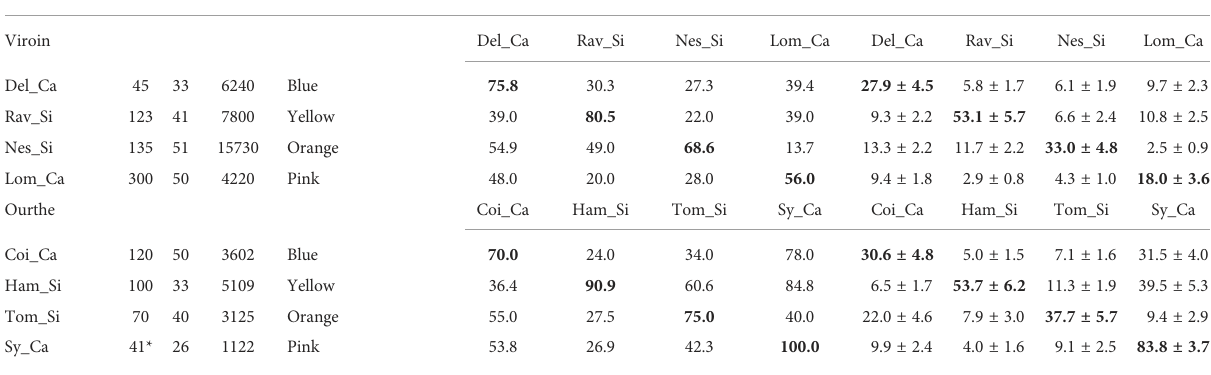
TABLE 1 Population details and dye dispersal results in eight populations of Silene nutans from the Viroin and the Ourthe valleys in southern Belgium. Population